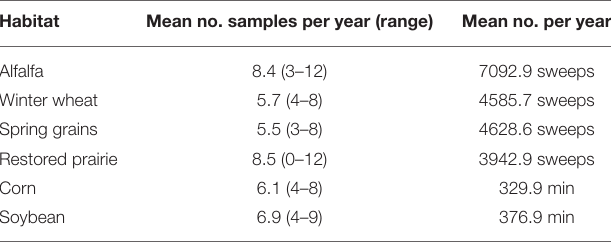
TABLE 1 | Mean number of sampling occasions per year in alfalfa, winter wheat, spring grains and restored prairie (sweepnet samples) and minutes sampled in corn and soybeans (timed visual searches) from 2007 to